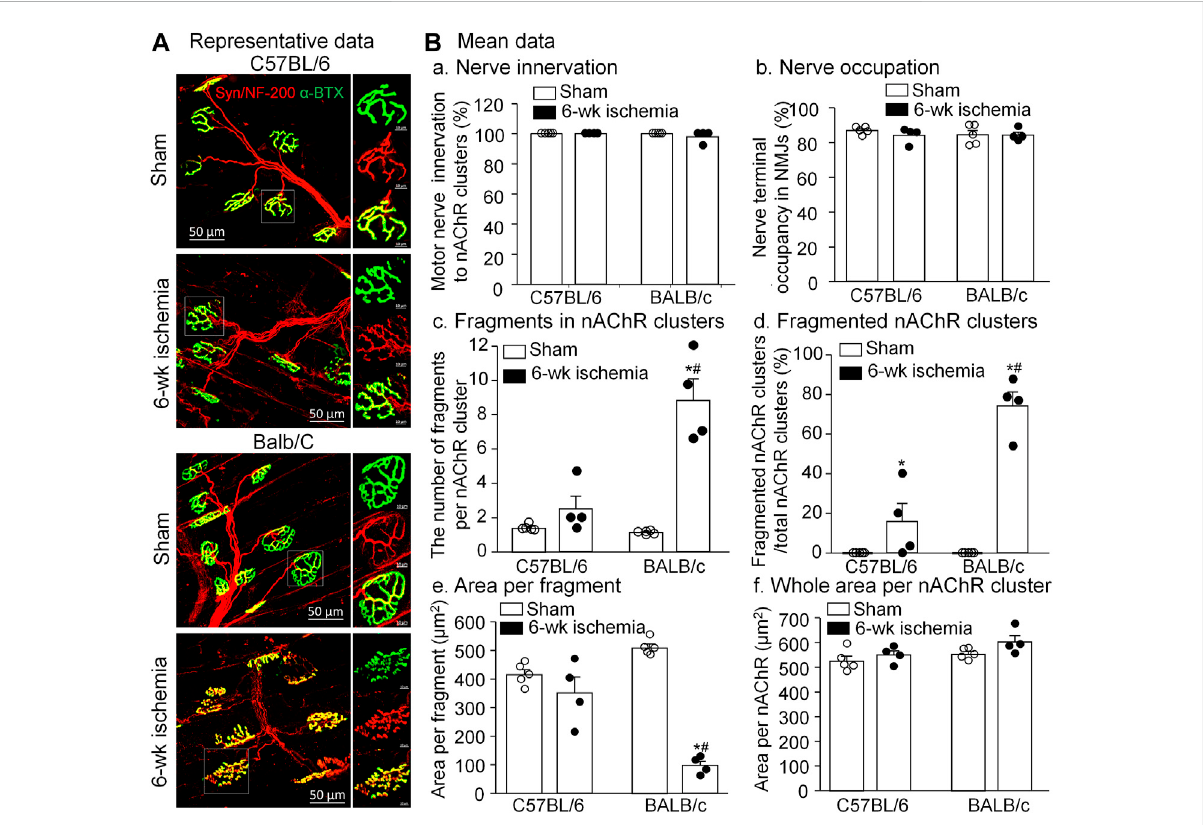
FIGURE 5 Morphologicalchangesofneuromuscularjunctions(NMJs)ingastrocnemiusmusclesinducedby6 weeksofthefemoralarteryligation(Isch)in C57BL/6 and BALB/c mice. (A) , representative immuno fl uorescence imagesof NMJs. Motor nerve axons and terminals (red color) werelabeled with neuro fi lament 200 (NF-200) and synaptophysin (Syn), and nicotinic acetylcholine receptors (nAChRs, green color) were labeled with Fluor ® 488- α - bungarotoxin ( α -BTX). Right insets in all groups illustrate ampli fi ed photomicrographs for one NMJ. (B) , summary data for some parameters of motor nerve terminals and nAChR clusters. Data are mean ± SEM, n = 5, 4, 5, and 4 mice in C57BL/6 sham, C57BL/6 Isch, BALB/c sham, and BALB/c Isch group, respectively. * p < 0.05 vs. C57BL/6 sham or BALB/c sham, respectively; # p < 0.05 vs. C57BL/6